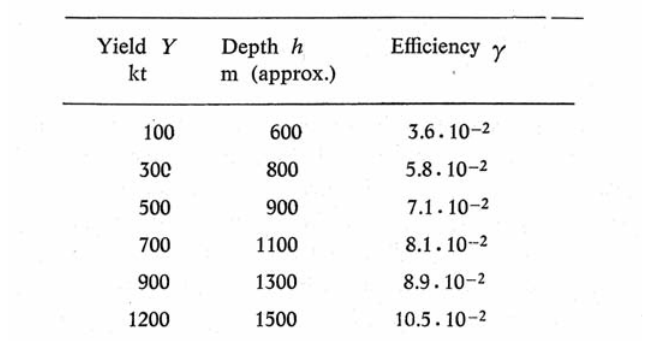
Table 7. Seismic efficiency γ of underground NTS